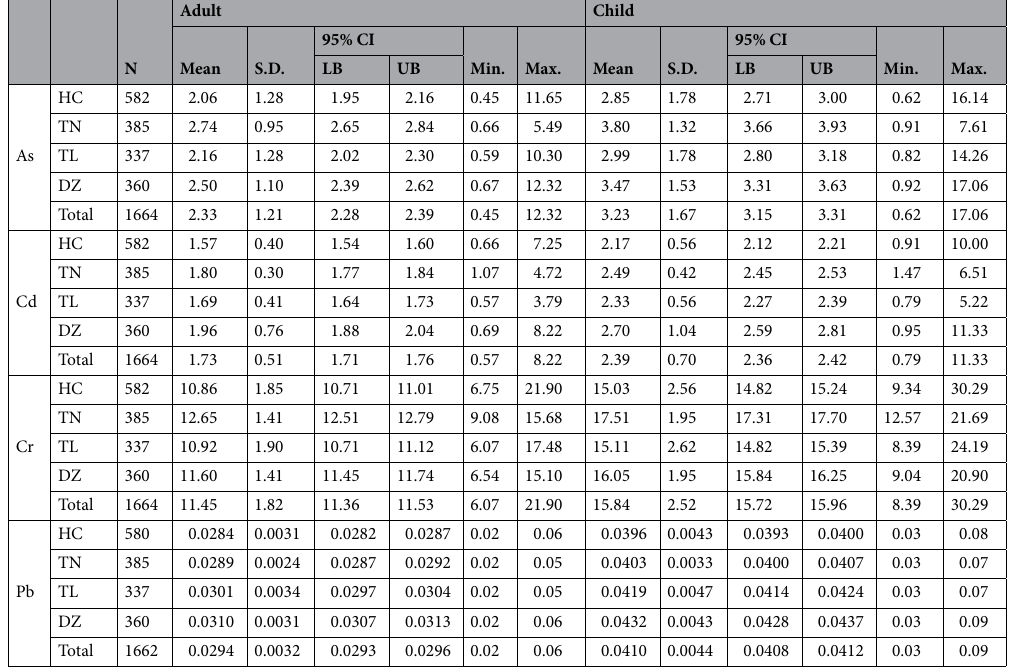
Table 3. Carcinogenic risk ( × 10 − 6 ) for different exposure pathways for adult and child (full name for abbreviations please see Table 1).